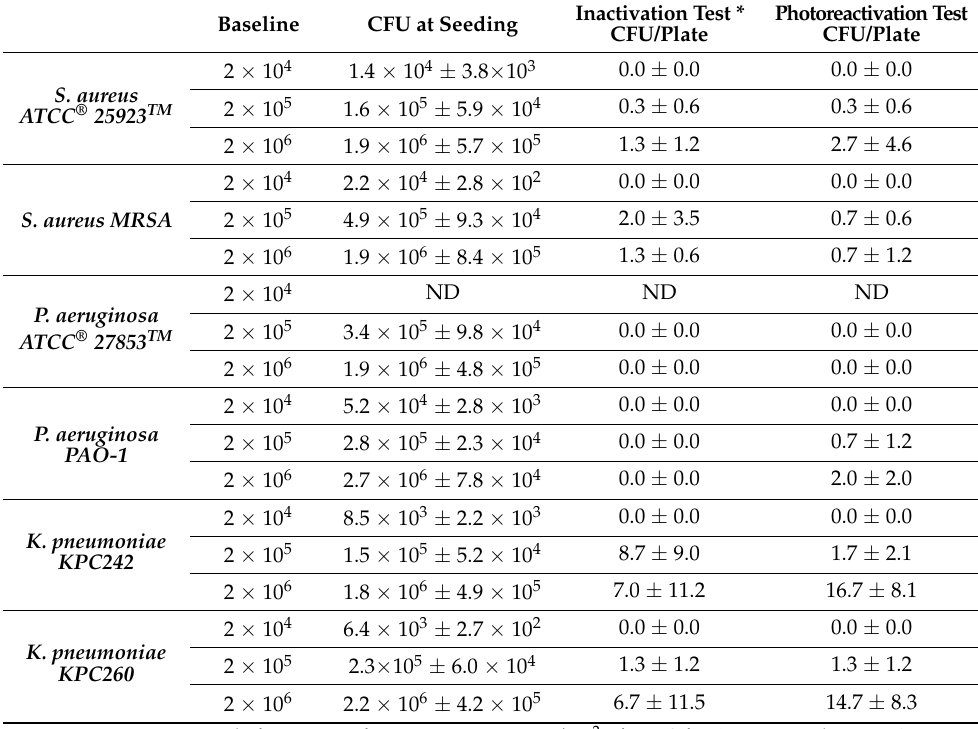
Table 1. Bacterial inactivation and photoreactivation after in vitro UV-C irradiation.